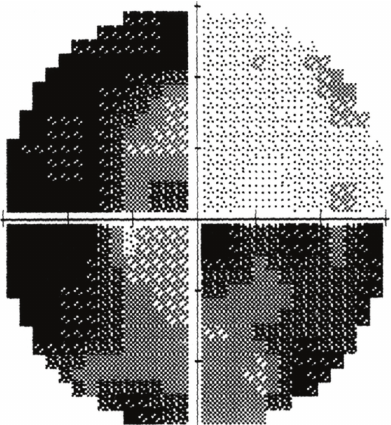
Figure 1: Preoperative left eye visual field. With stimulus V, there was loss of three quadrants with only the superonasal quadrant showing a good degree of preservation.